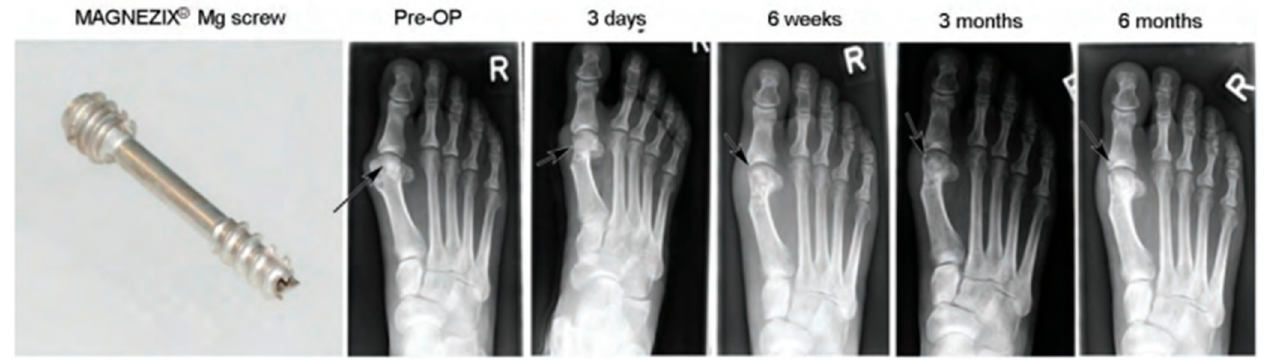
Figure 3. Bunion correction surgery.